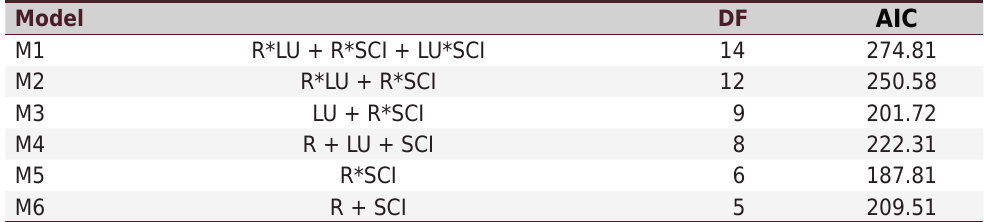
Table 7. Linear mixed models, associating different parameters to predict soil loss from a Typic Hapludox in Lavras, MG, Brazil